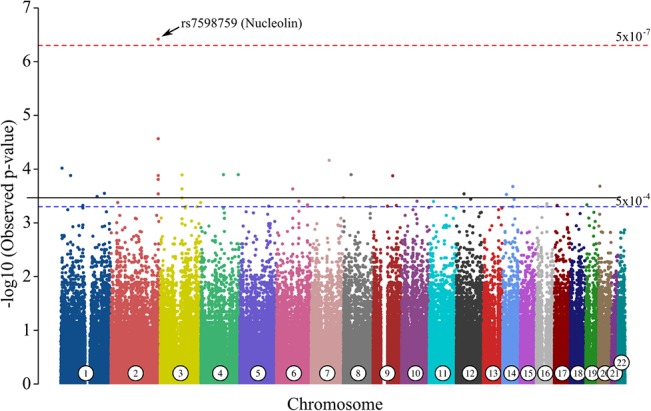
Manhattan plot of the SNPs associated with NIHL.Genome-wide significant SNP rs7598759 is located within nucleolin gene on chromosome 2 (black arrow). The-log10 of the p-value (y-axis) for each of the analyzed SNPs is shown with respect to their genomic location (x-axis) with chromosomes in alternate colors. Dashed lines indicate thresholds for genome-wide association (p < 5 x 10−7, red) and suggestive association (p < 5 x 10−4, blue).